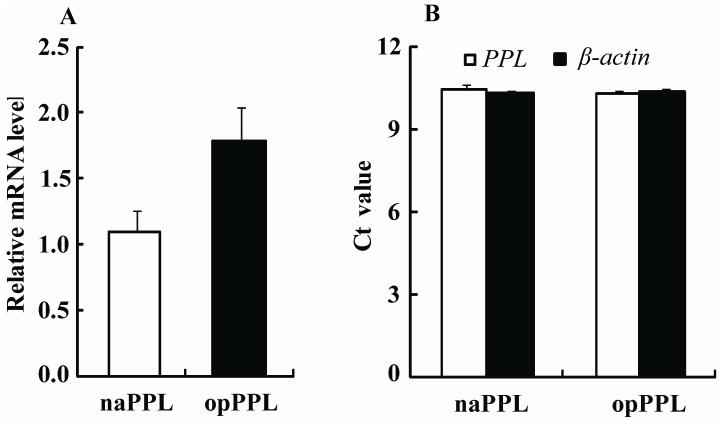
Comparison of the target gene relative mRNA profiles (A) and gene copies numbers (B) between the P.pastoris opPPL//pPICZαA and naPPL/pPICZαA.